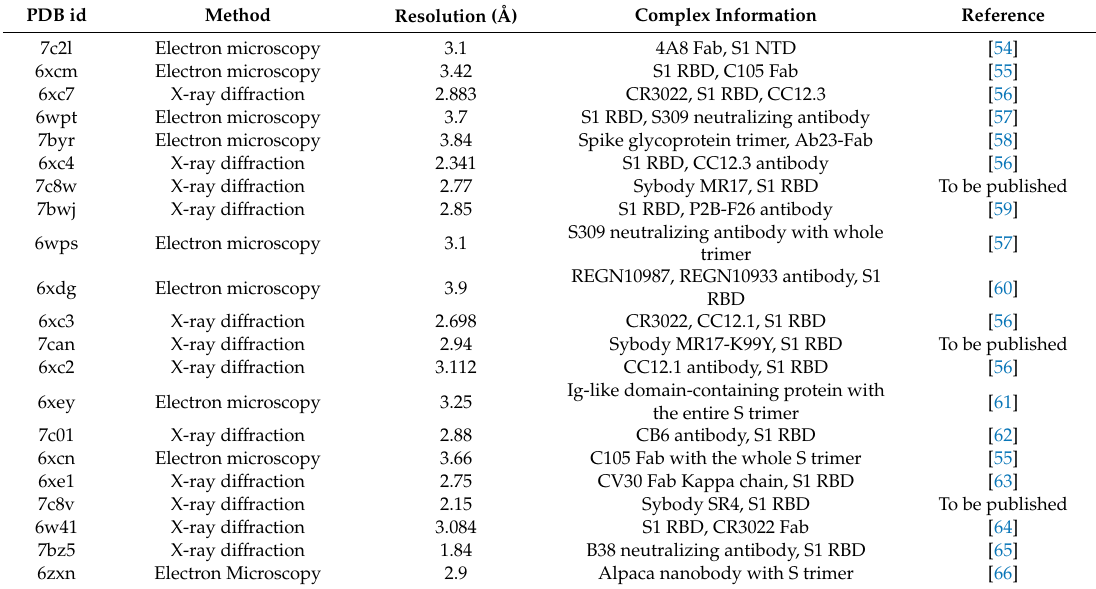
Table 1. Structures of antibody complexes with S glycoprotein components.